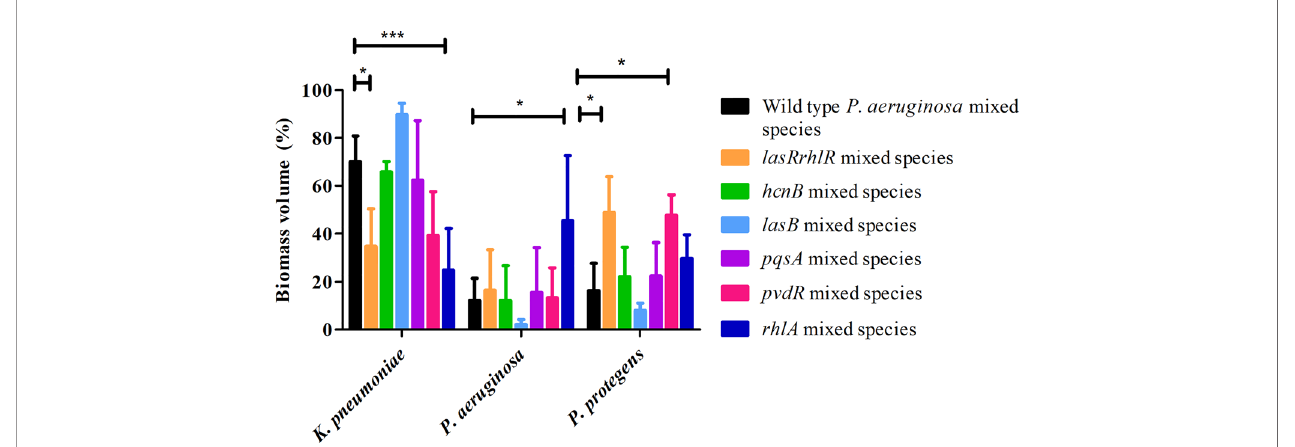
FIGURE 6 | Proportions of mixed species bio fi lm containing mutants of QS regulated effectors. The proportions of the three species in the mixed species bio fi lm containing either the P. aeruginosa wild type, the QS mutant lasRrhlR or the QS target mutants hcnB , lasB , pvdR , rhlA , or pqsA after 3 days of cultivation. Bar charts depict the percentages of K. pneumoniae , P. aeruginosa and P. protegens in the wild type or the mutant mixed species bio fi lms. The proportions were derived by cultivating bio fi lms under fl ow cell conditions followed by quantitative image analysis of 2 independent biological replicates. Error bars represent standard deviations (n = 2). * and *** denote signi fi cant difference by two-way ANOVA followed by Tukey ’ s post-test ( P < 0.05; P <